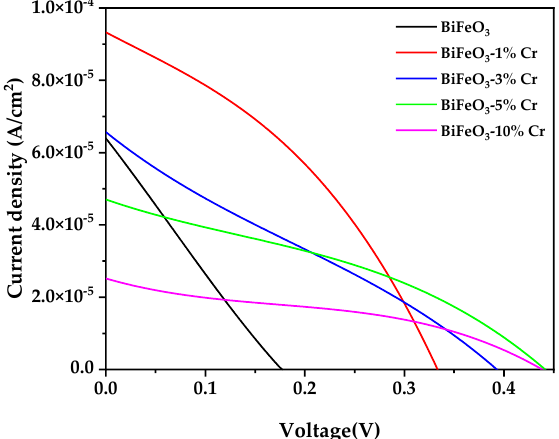
Figure 5. Scanning electron microscopy images (bar 5 μ m) of ( a ) Pure BiFeO 3 , ( b ) BiFeO 3 -1% Cr, ( c )